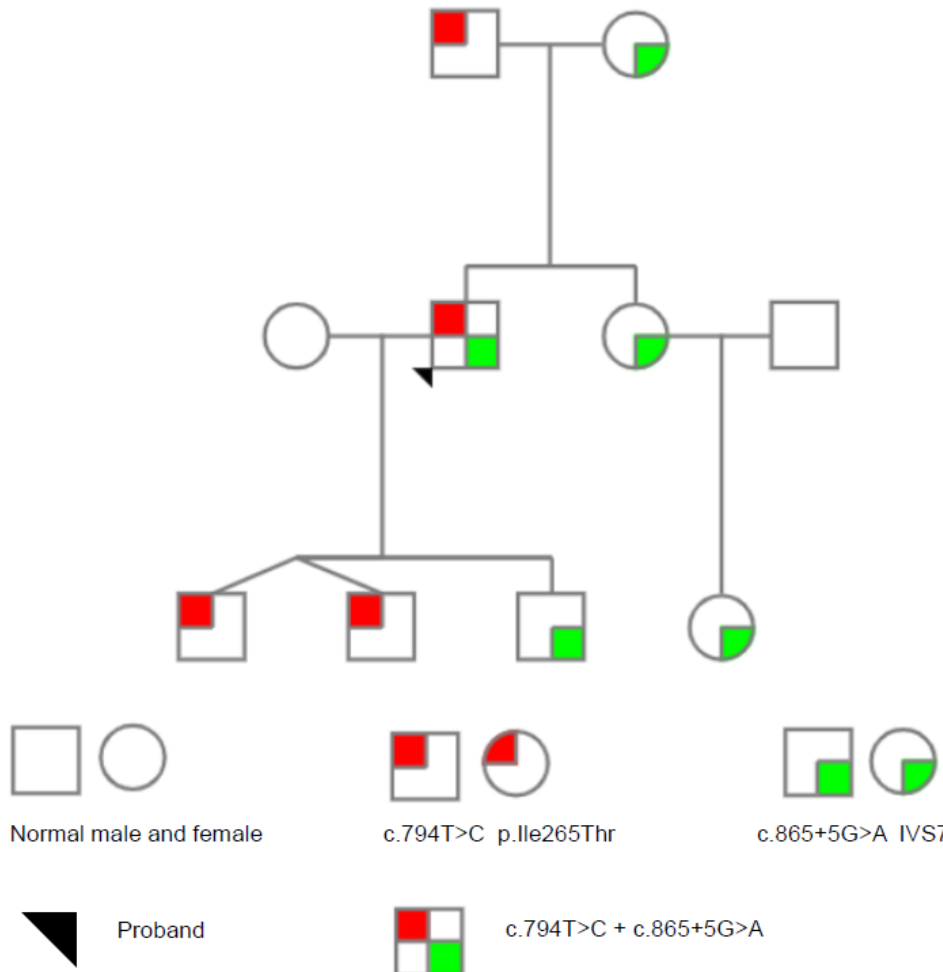
Figure 1. The pedigree of the proband with FX deficiency. The proband is compound heterozygous with c.794T > C and c.865 + 5G > A. Genetic analysis of the family members showed that his mother, sister, niece and elderly son are heterozygous for c.865 + 5G > A. His father and twin sons are heterozygous for c.865 + 5G > A.